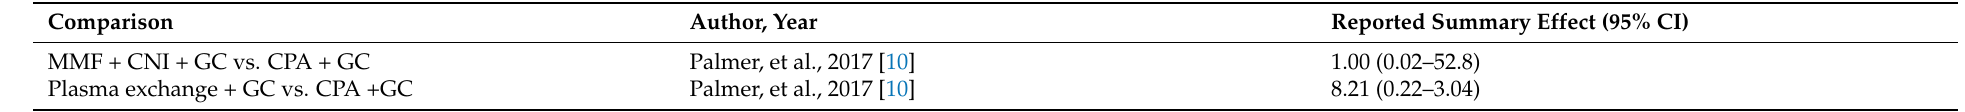
Table 15. Mortality during induction and maintenance therapy of lupus nephritis (Network